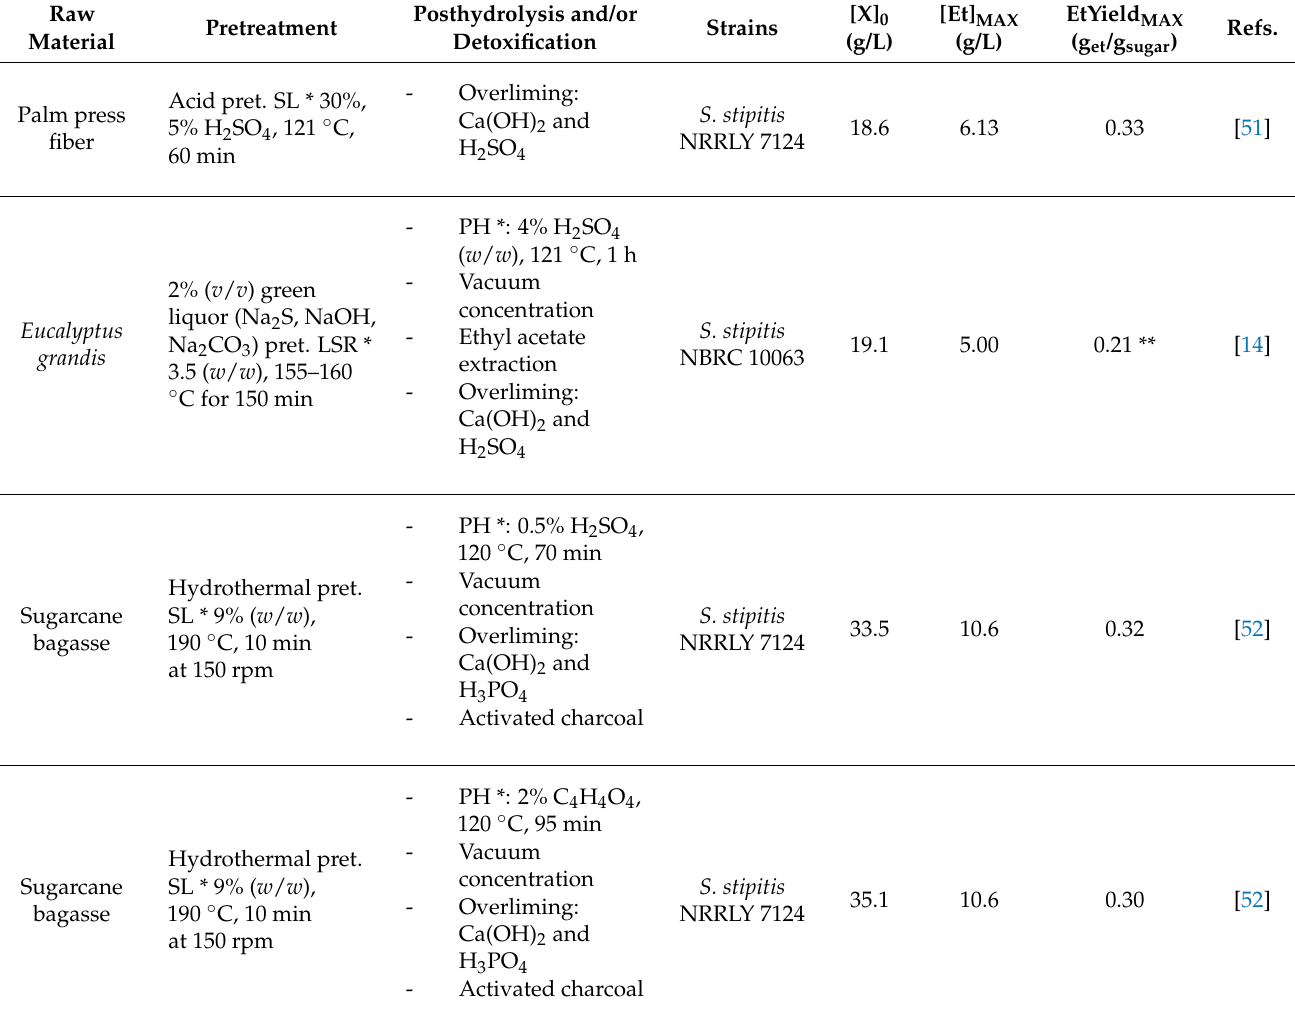
Table 3. Comparison of fermentation results using different hemicellulosic